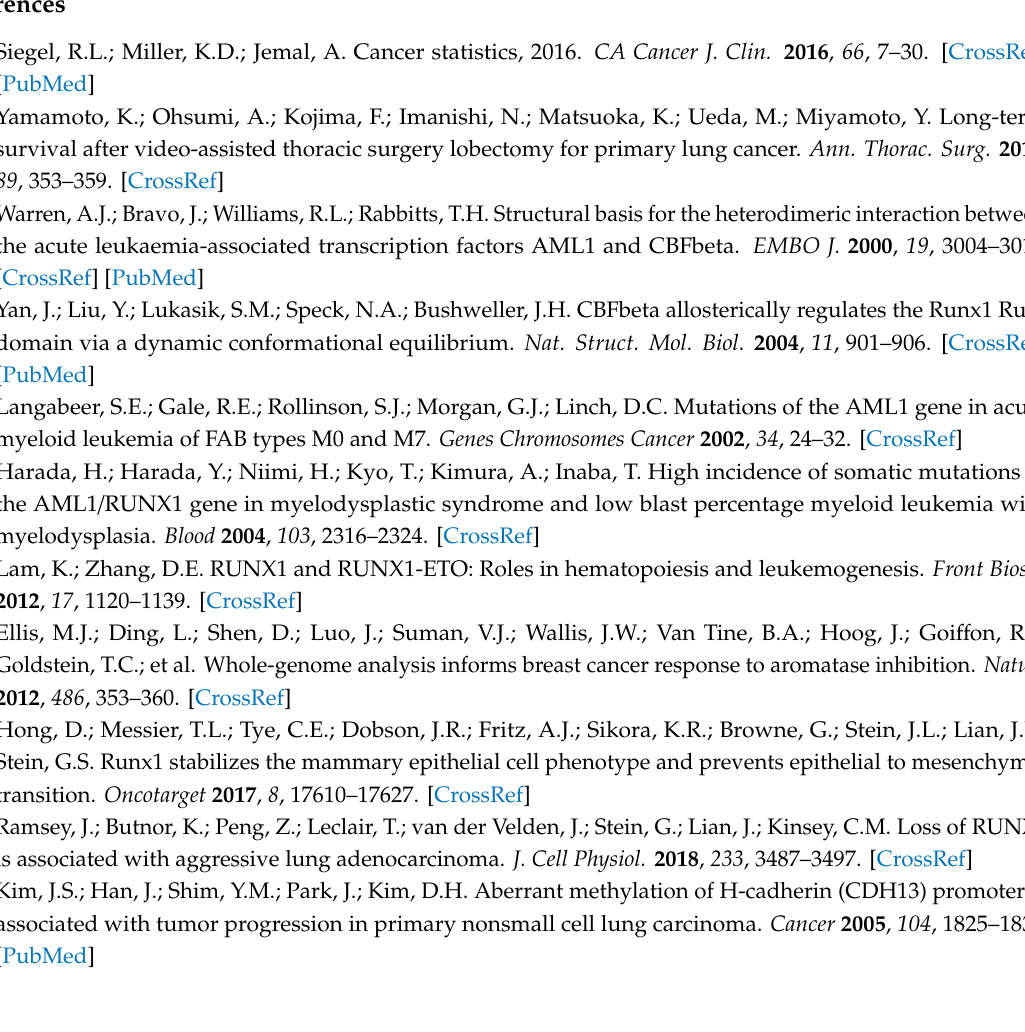
Table S1: Prediction performance of logistic regression model based on three CpGs in a test dataset (N = 269) of TCGA lung cancer. Table S2: Clinicopathological characteristics. Supplementary Figure S1: Relationship between di ff erentiation and RUNX1 methylation. Supplementary Figure S2: Association between RUNX1 expression and pathologic